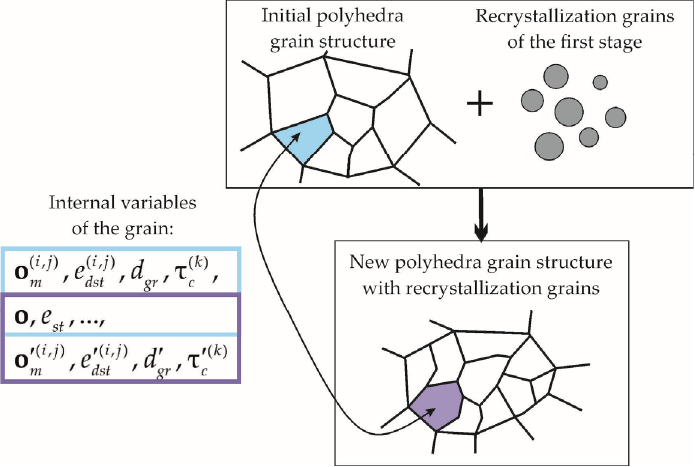
Figure 2. The scheme of the method to establish correspondence between the initial grain structure and the rearranged structure, due to emergence of recrystallized grains.